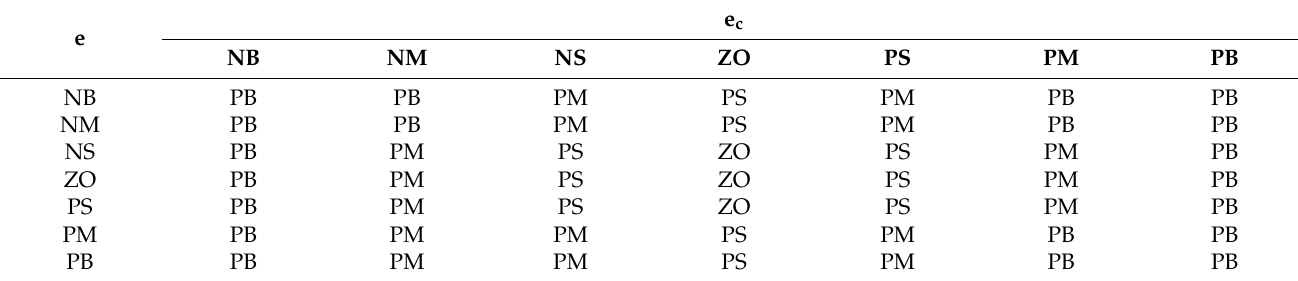
Table 1. The fuzzy rules matrix of ∆ k p .